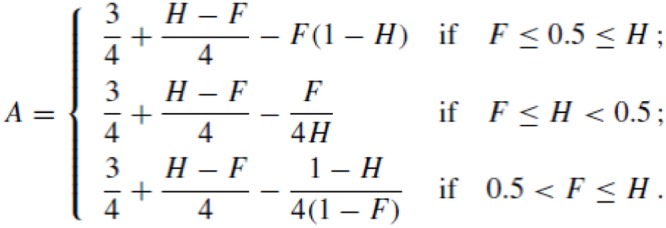
Formula used to compute the SDT A scores.